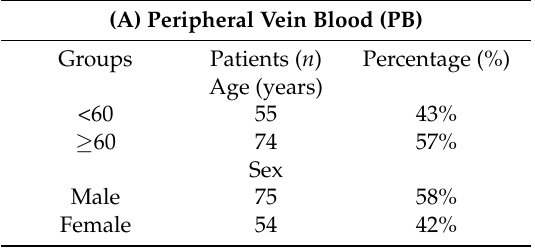
Table 1. Demographics of patients. Age, sex, tumor location, and TNM (Tumor, Nodes, Metastasis- classification) stages were separately analyzed for patients with peripheral blood (PB) ( A ) or inferior